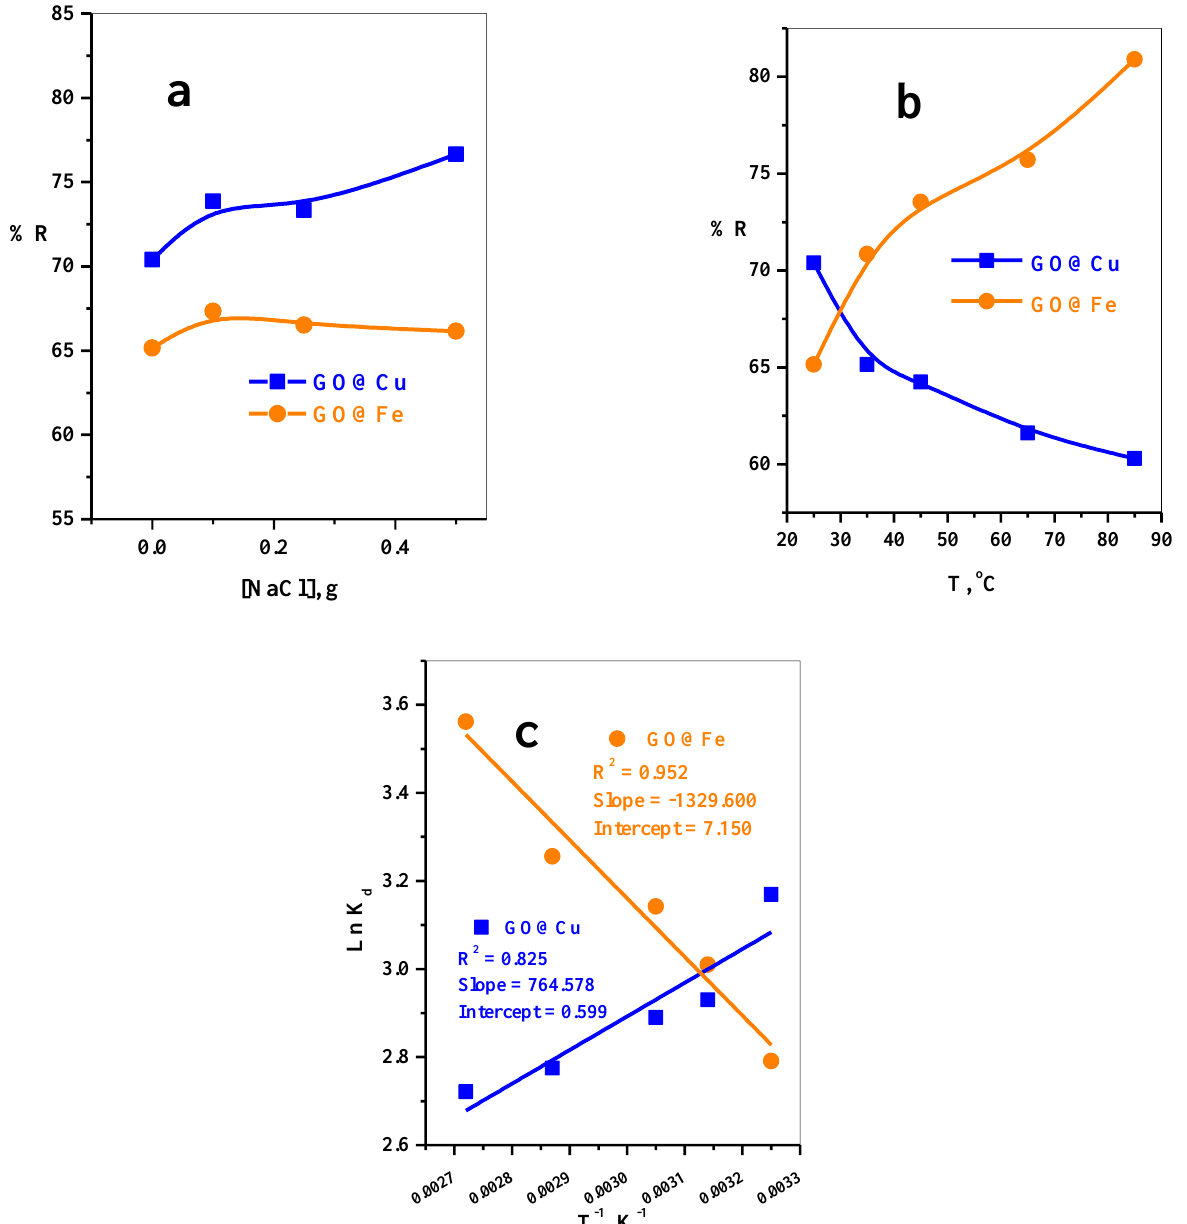
Figure 9. The effect of ( a ) sodium chloride dose, ( b ) solution temperature on the removal efficiency of MB using GO@Cu, and ( c ) Thermodynamic plots (t = 2.5 min, [MB] = 50 mg L − 1 , dose = 5 mg, V = 50 mL, T = 25 ◦ C) and GO@Fe (t = 2.5 min, [MB] = 30 mg L − 1 , dose = 6 mg, V = 50 mL, T = 25 ◦ C) from aqueous medium.